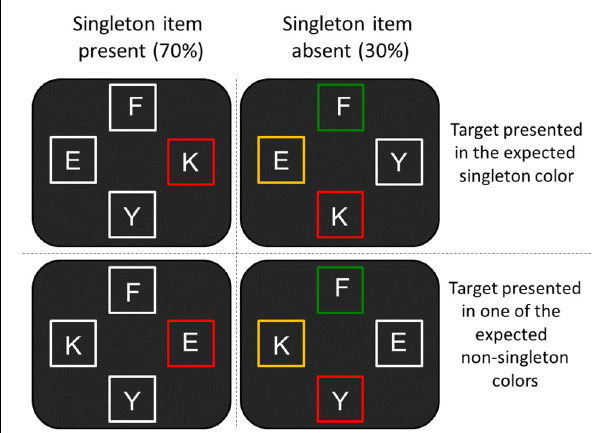
FIGURE 3 | Examples of the stimulus displays used in Experiment 2. In these examples, the expected color singleton frame is red. Participants completed four blocks. In each block, one color was the singleton color throughout the block. Each color from the four options (red, yellow, green, and white) had its turn as the singleton